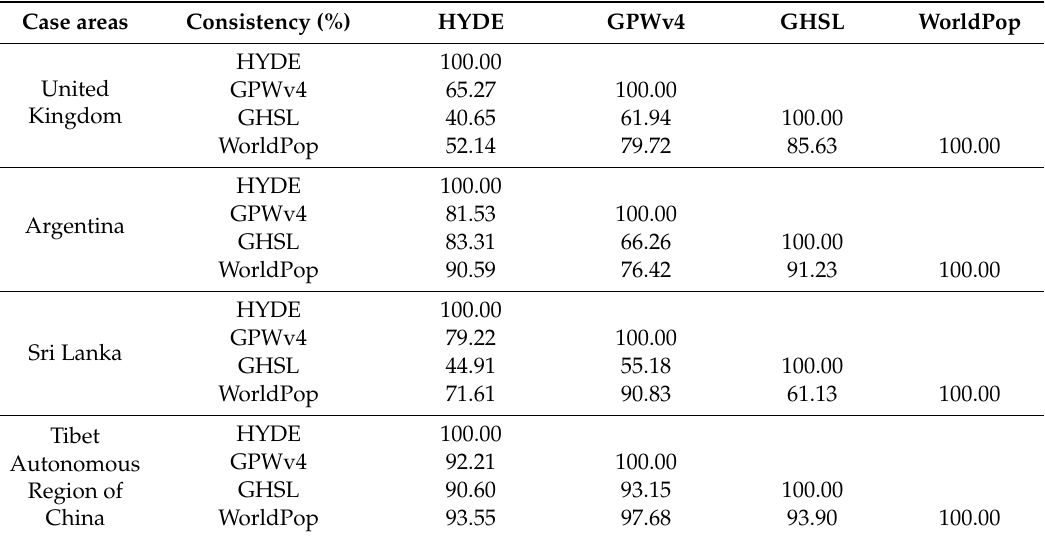
Table 6. Comparative analysis of spatial consistency of data